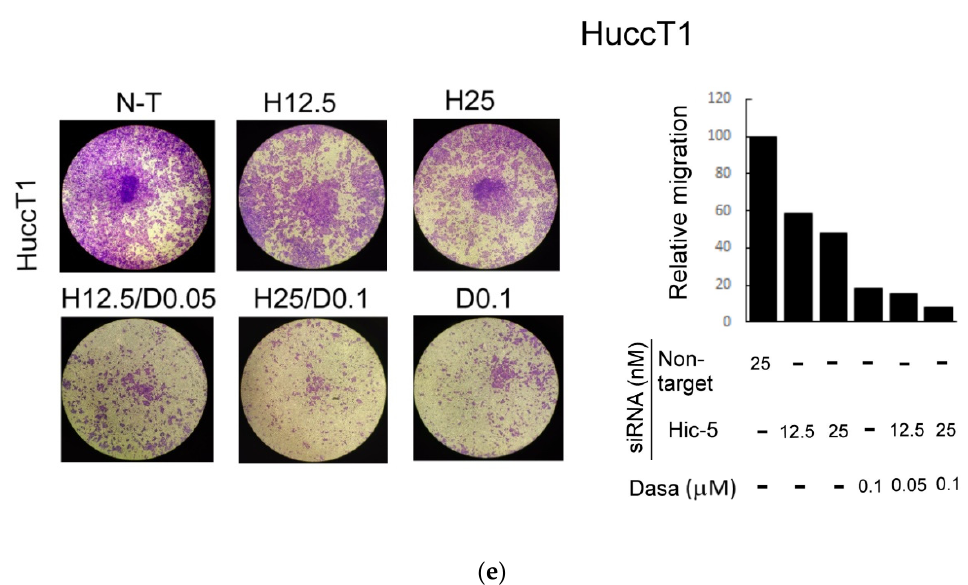
Figure 4. Src-Hic-5 signal cascade is essential for HuCCT cell migration. HuCCT1 cells were pre-treated with Src inhibitor PP1 ( a ) and dasatinib ( b ) at indicated concentrations for 24 h ( a ); HuCCT1 were transfected with Hic-5 siRNA at the indicated concentration for 24 h ( c ); HuCCT1 were transfected with Hic-5 siRNA for 24 h at the indicated concentration, followed by pre-treatment with Src inhibitor PP1 ( d ), and dasatinib ( e ) at the indicated concentration for 24 h. Wound healing culture ( a , c , d ) and trans well migration assay ( b , e ) were performed. In wound healing assays ( a , c , d ), pictures were taken at 0 and 24 h after the cells begin to move into the wound area between lines. The motility of the cells was compared by the difference of the cell migrated into the wound area at 24 h. In trans well migration assay ( b , e ) pictures were taken after dasatinib treatment for 24 h ( b ) or transfection with Hic-5 siRNA for 24 h followed by treatment with dasatinib for 24 h ( e ). Quantitative data of ( b , e ) for estimating the intensity of migrated cells on each subfigure using Image J. software were shown in the right panel of each figure. Relative migrations were calculated taking the data of vehicle ( b ) or nontargeting (N-T)siRNA group ( e ) as 100%. The data shown were averages of two reproducible results with C.V. as 10%. In ( b ), Dasa: dasatinib, In ( e ), N-T: nontargeting, H: Hic-5siRNA (nM), D: dasa ( µ